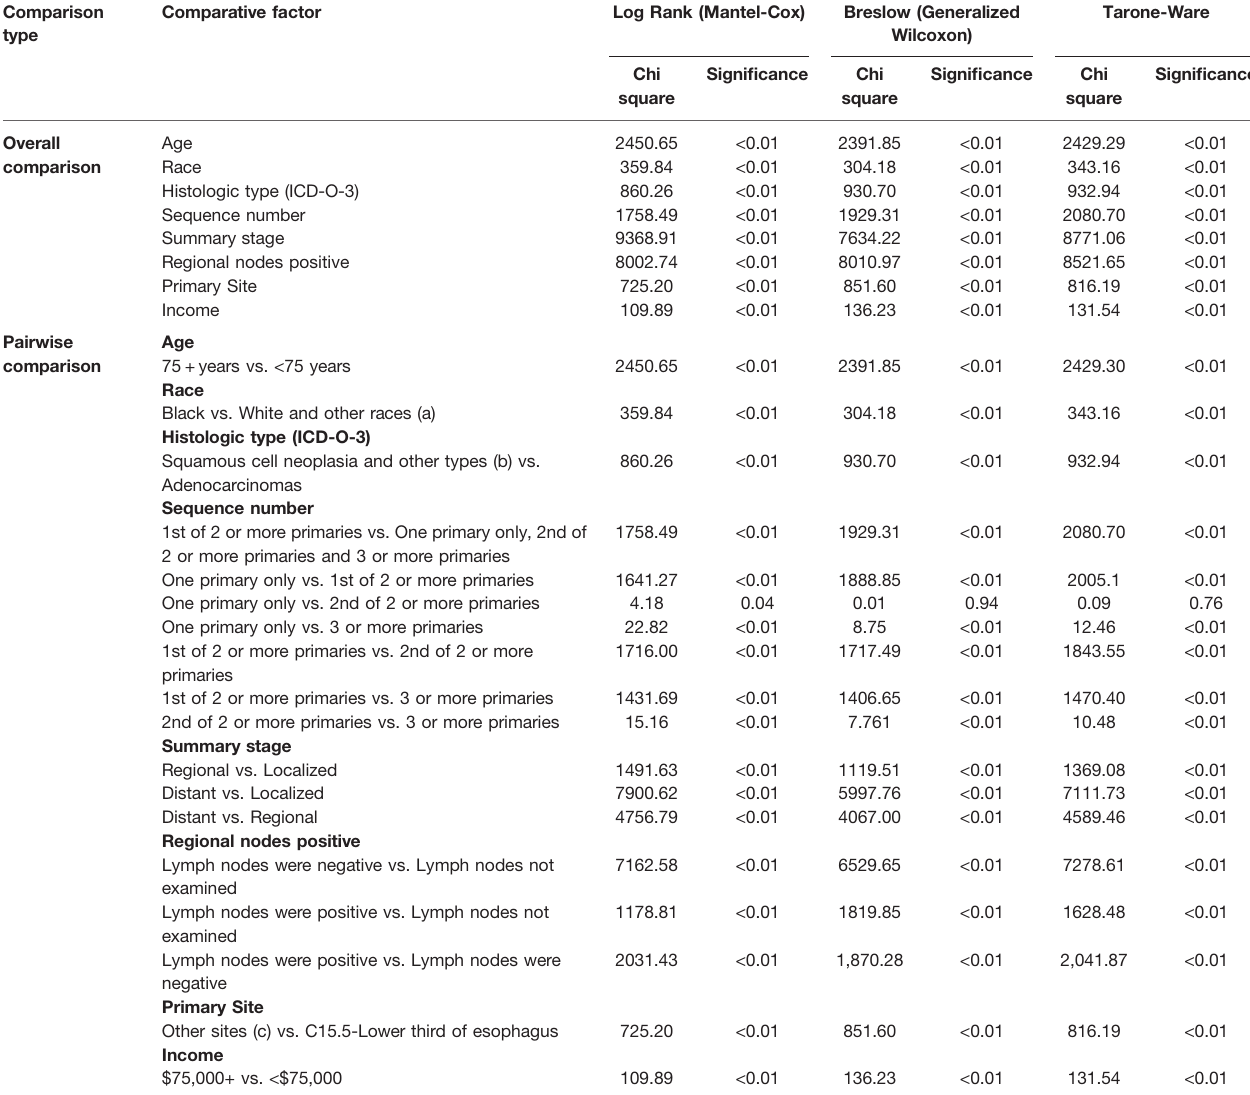
TABLE 3 | Overall comparison and pairwise comparison of each group in Kaplan-Meier survival